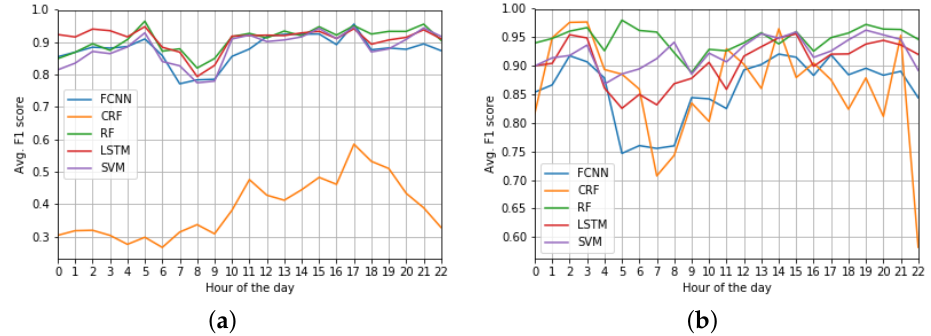
Figure 14. Average F1 score per hour of the day of each of the evaluated models considering both OSN and taxi demand data as input. ( a ) QUADRIVEN models; ( b ) Taxi-demand